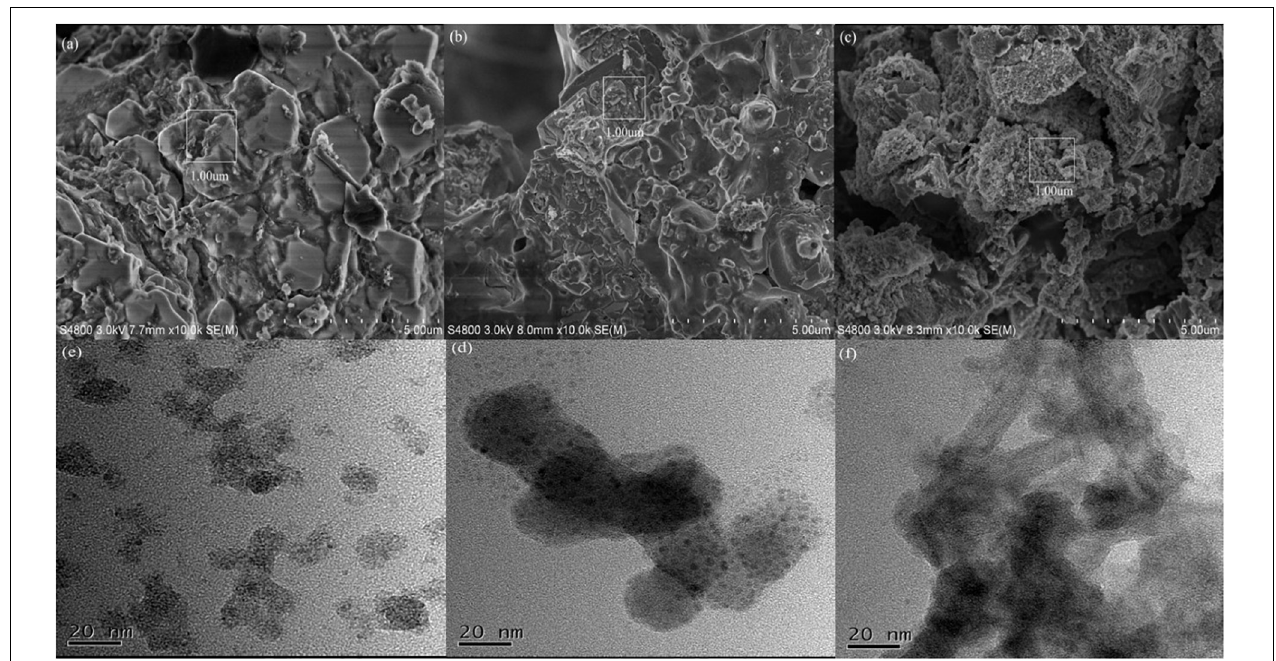
FIGURE 1 | Scanning electron microscopy (a–c) with 5 times magnification of the specified area (1 µ m) and transmission electron microscopy (d–f) images of OMC, FeOMC, and TriFeOMC,